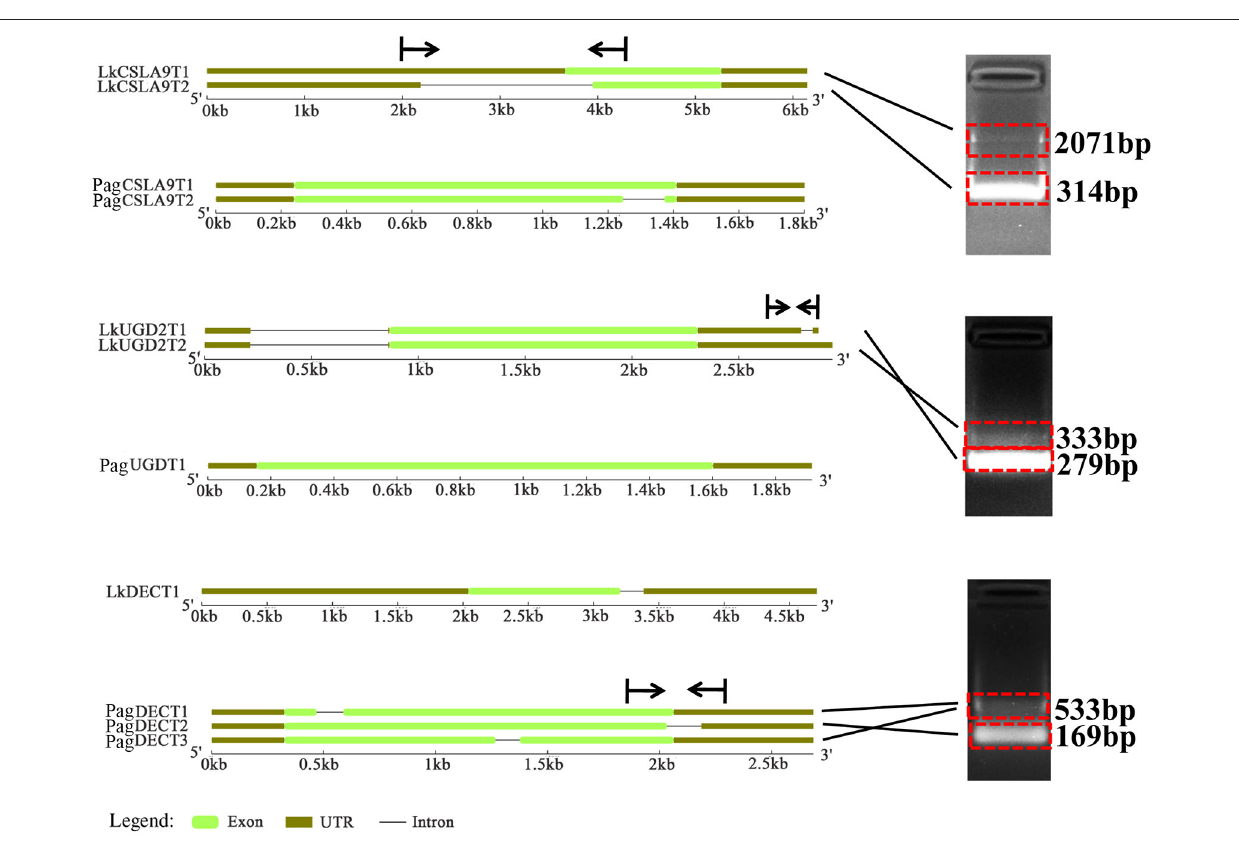
Frontiers in Plant Science |